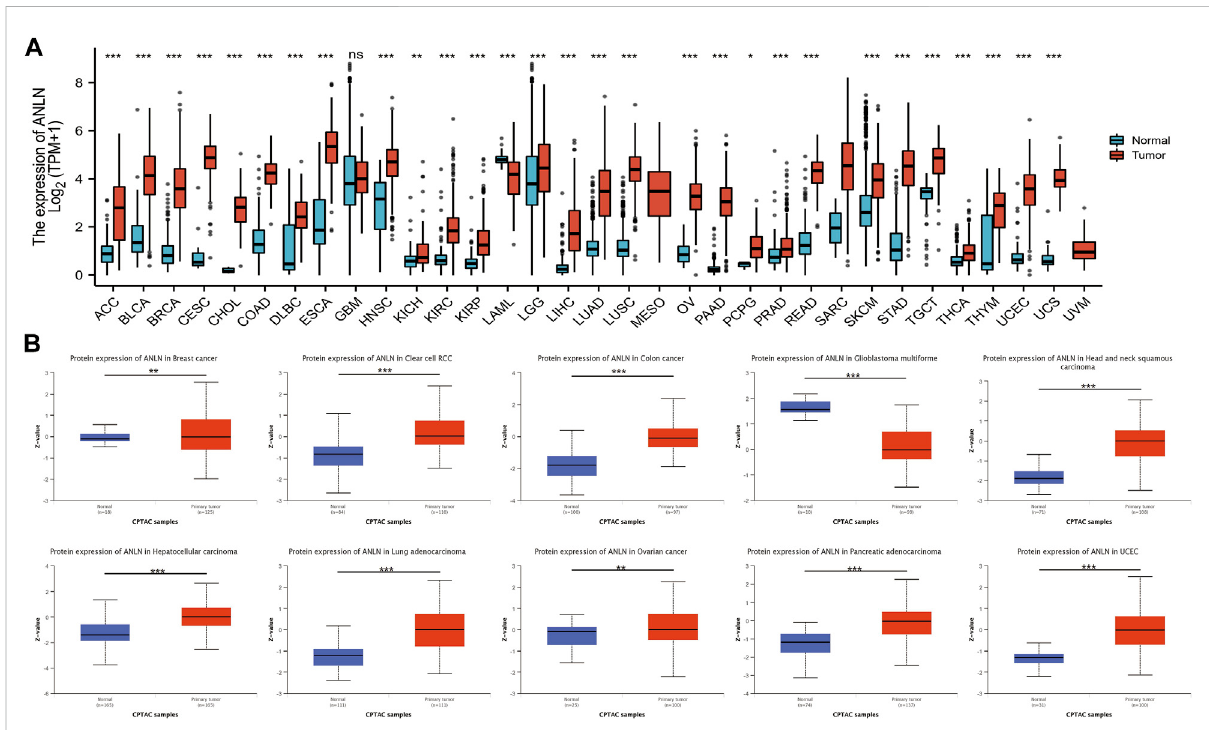
FIGURE 3 Upregulation of ANLN mRNA expression in pan-cancer. (A) Expression levels of ANLN in TCGA_GTEx database in different cancer types. Log2 (TPM + 1) was used for log scale. (B) Expression levels of ANLN protein in normal and different tumor tissues from the CPTAC database. * p < 0.05, ** p < 0.01, and *** p <